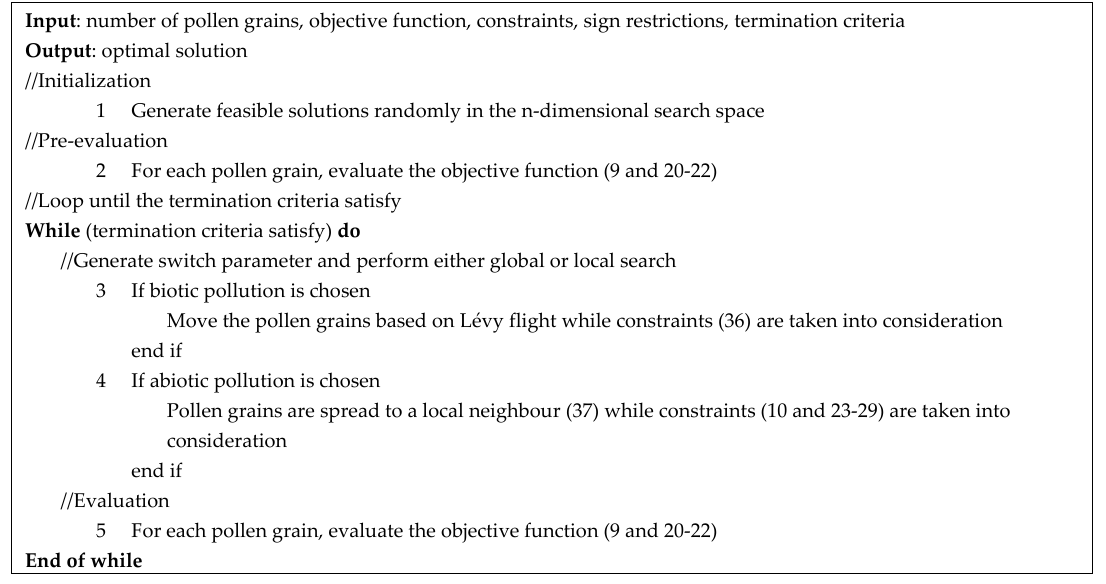
Figure 15. Pseudocode of the implementation of flower pollination algorithm for extended and real-time rescheduling and reassignment of supply routes.